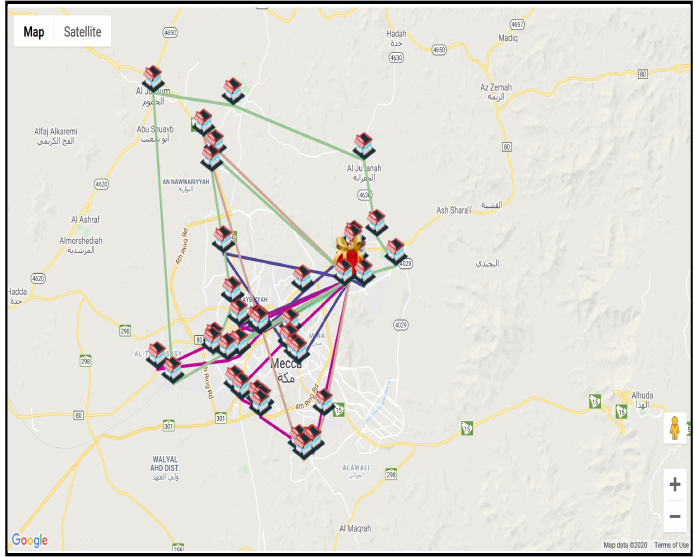
Figure 5. Route plan proposed by the Ekram system after applying VRP.